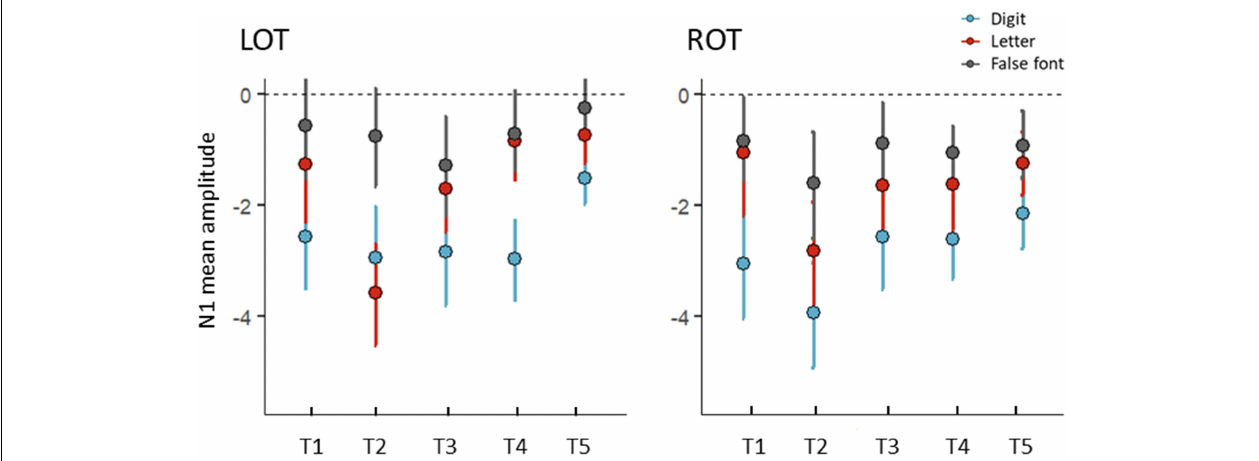
FIGURE 4 | Mean amplitudes ( µ V) for the N1 interval over the five time points (T1, T2, T3, T4, and T5) for digits (blue), letters (red), and false fonts (black). Left (LOT) and right (ROT) electrode clusters are shown in separate panels. Error bars represent 95% CI. Normalized residuals from the main model exceeding ± 3 threshold were excluded (7 data points).